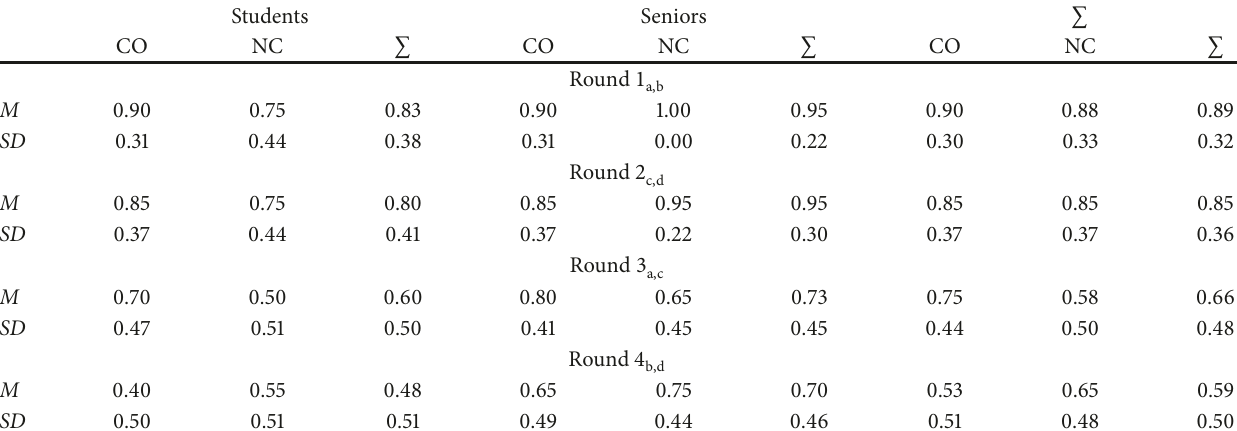
Table 1: Means of participants’ decision to cooperate for all four